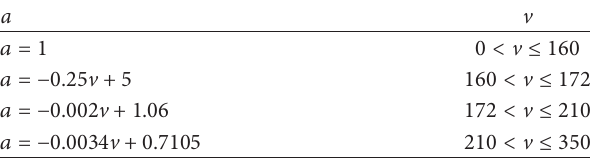
Table 2: The relationship between a and v